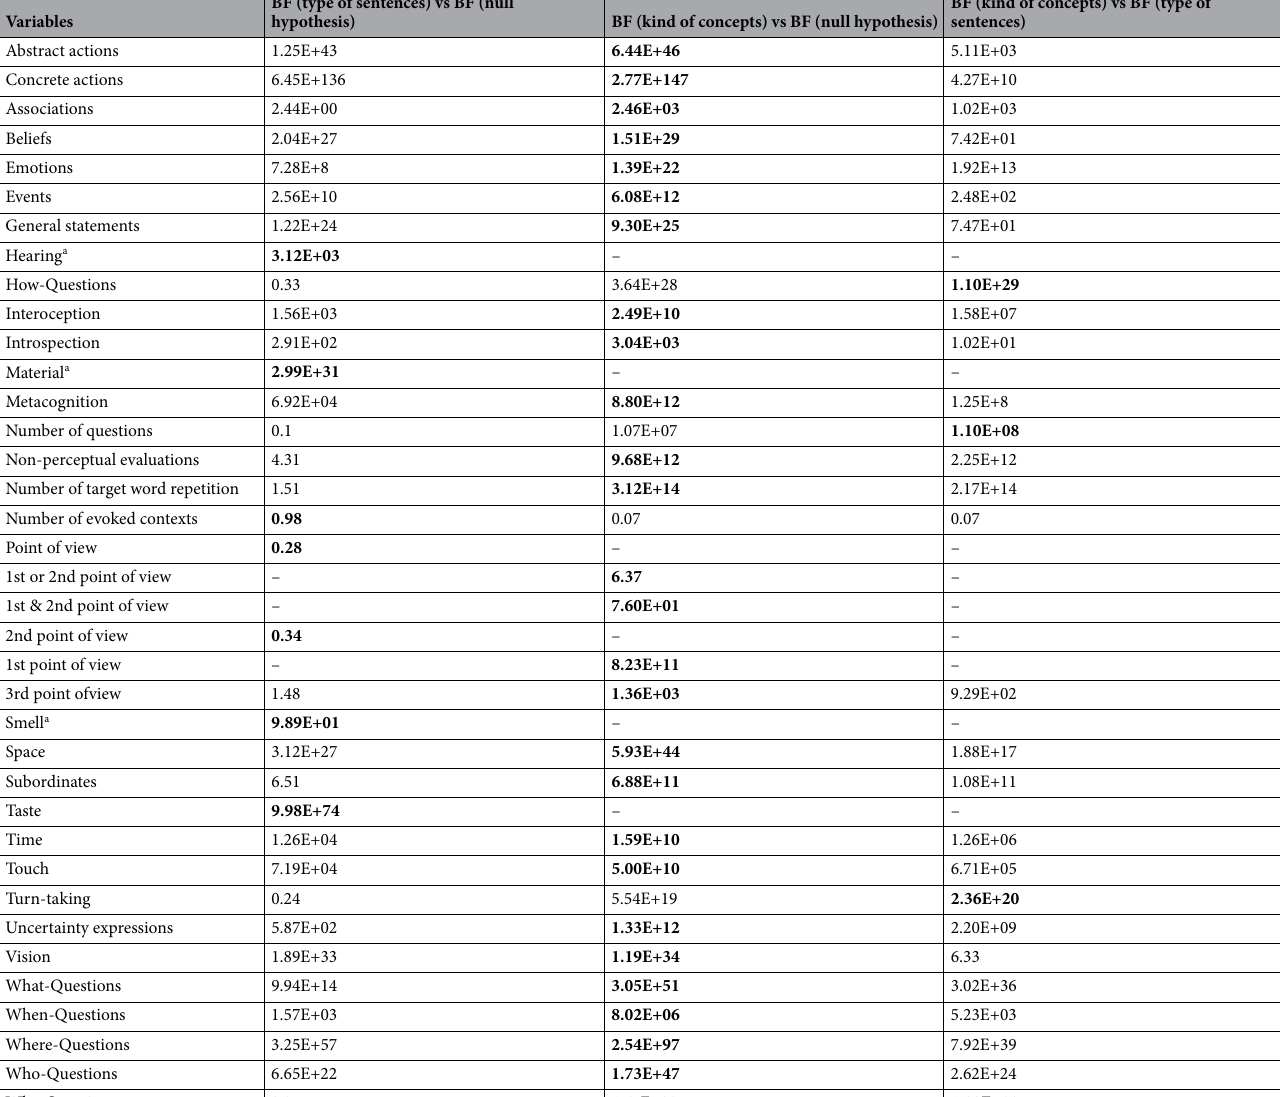
out using the Kind of concepts as the factor with the Null Hypothesis (only intercept) (second column); the Type of sentences and the Kind of concepts models (last column). The BFs values highlighting meaningful differences are in bold. The BF values in bold are those that show a highest difference between the models. This value has helped us in the choice of the models to consider for the analyses. a Due to few elements in the variable only the comparison between Type of sentences and Null Hypothesis was carried